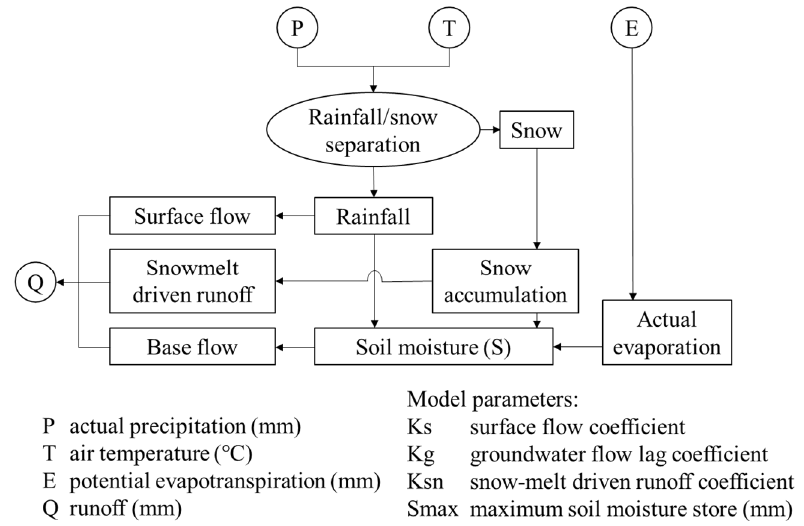
Figure 2. The structure and description of the RCCC-WBM model.